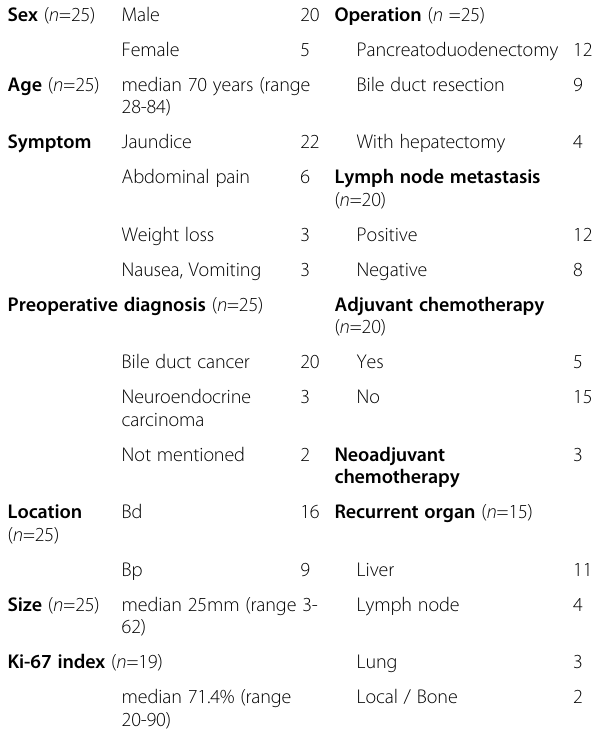
Table 2 Summary of 25 reported cases of primary extrahepatic bile duct neuroendocrine carcinoma